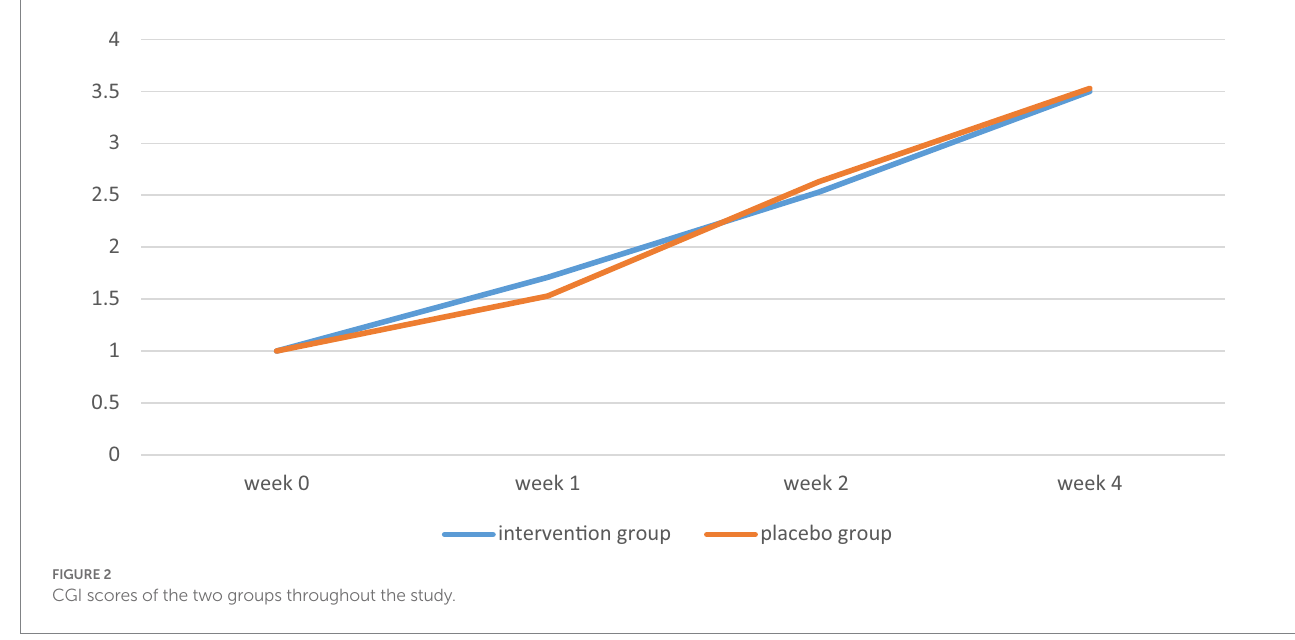
FIGURE 2 CGI scores of the two groups throughout the study.